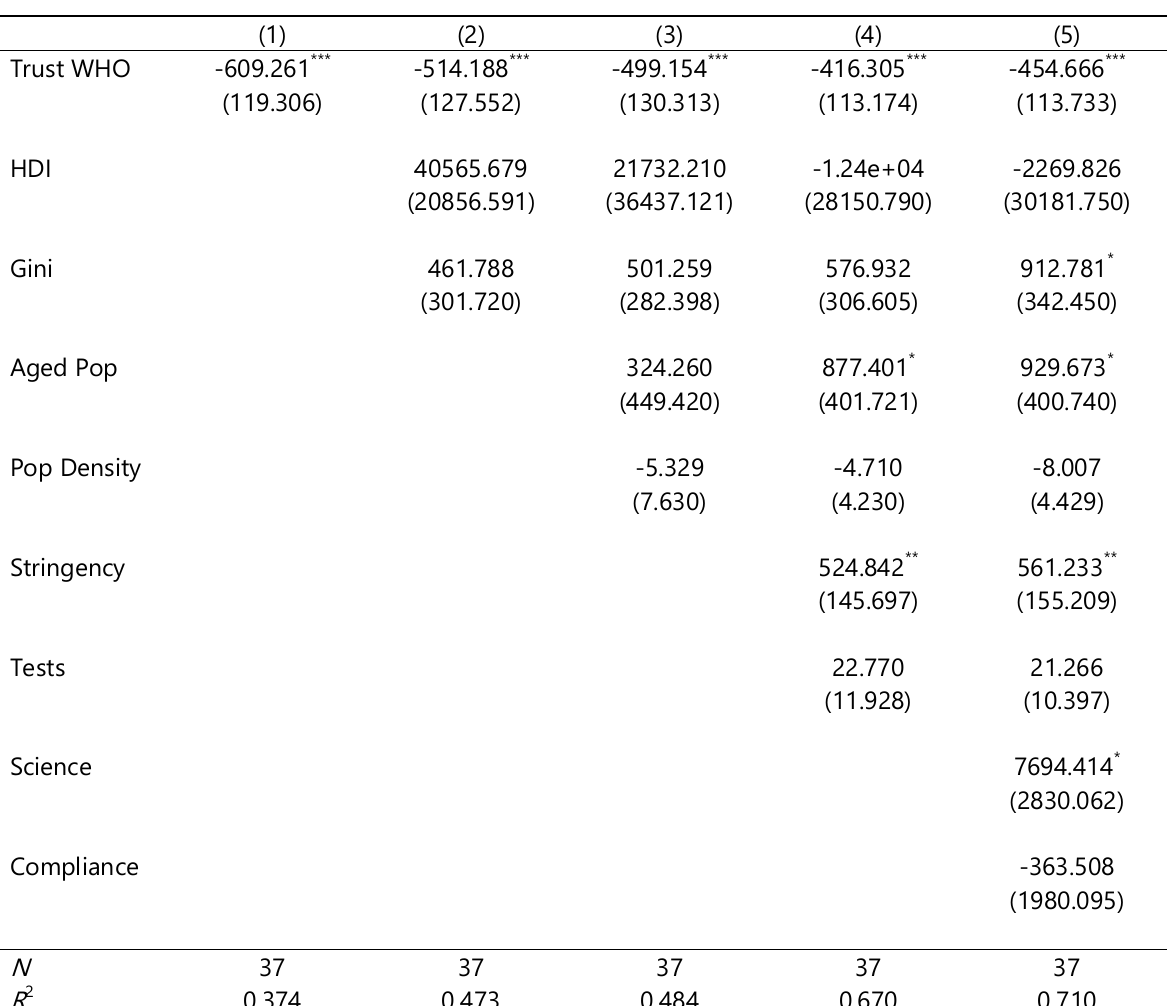
Table 1: Results of OLS